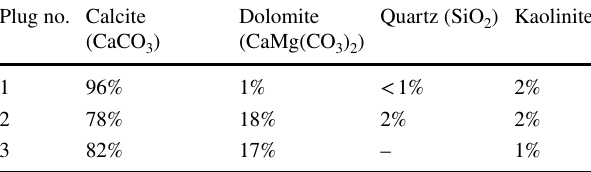
Table 3 Composition of core samples determined by XRD